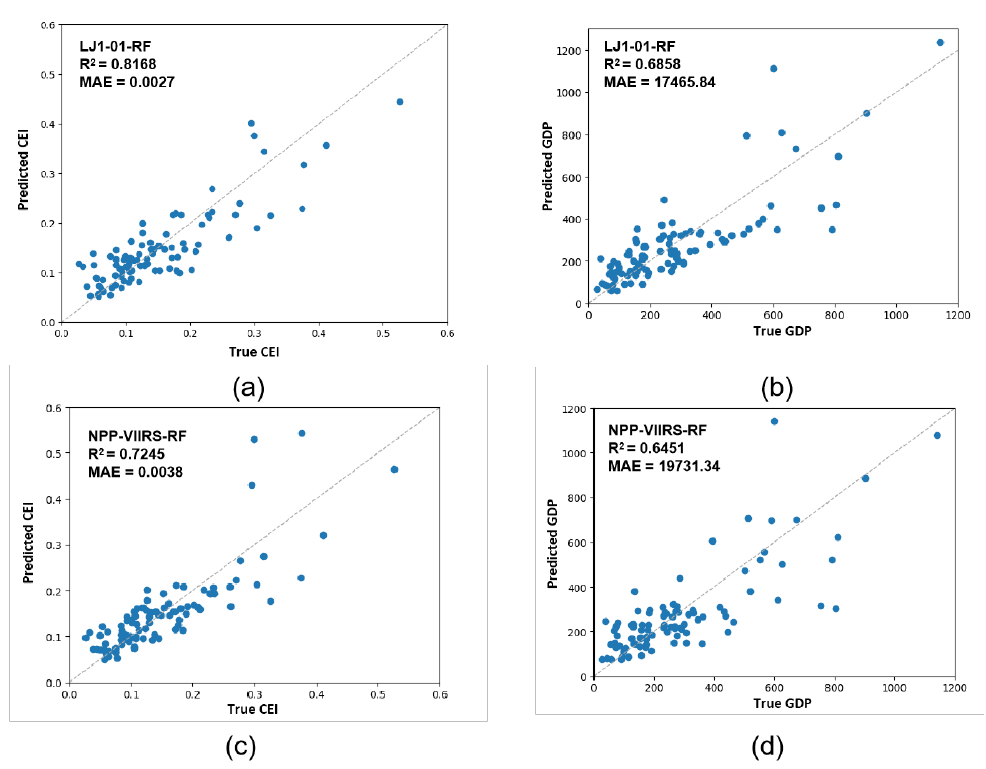
Figure 7. Scatter diagrams of the RF regression model for the CEI and GDP: ( a ) prediction of CEI using LJ1-01 NTL data; ( b ) prediction of GDP using LJ1-01 NTL data; ( c ) prediction of CEI using NPP-VIIRS NTL data; and ( d ) prediction of GDP using NPP-VIIRS NTL data.